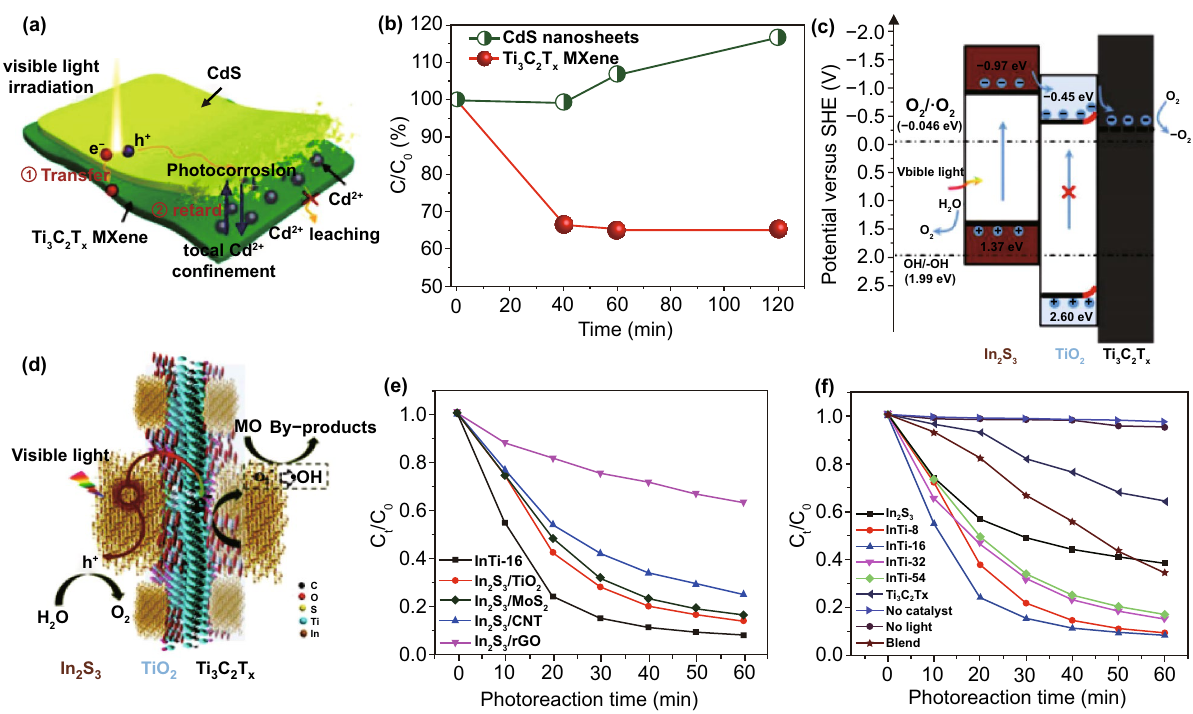
Fig. 23 a Scheme of CdS/Ti 3 C 2 T x NSs to improved photo‑activity and photo‑stability. b Adsorption of Cd 2+ over CdS NSs and Ti 3 C 2 T x MXene in dark. Adapted with permission from Ref. [261]. c Charge migration. d Separation and reaction mechanism for MO degradation in In 2 S 3 / anatase TiO 2 @metallic Ti 3 C 2 T x (InTi) system after vis‑light and photo‑catalytic degradation of MO over other In 2 S 3 ‑based binary hybrids. e In 2 S 3 , In Ti hybrids, and Ti 3 C 2 T x . f In Ti‑ x indicates mass of Ti 3 C 2 T x included during preparation ( x = 8, 16, 32, and 54 mg). Adapted with per‑ mission from Ref.